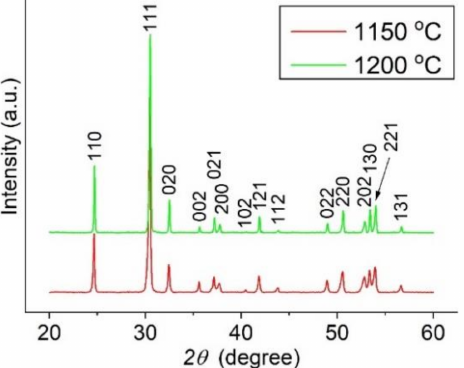
Figure 2. XRD patterns for annealed ZST Samples A and B (Table 1) obtained for sintering tempera- tures of 1150 ◦ C and 1200 ◦ C,